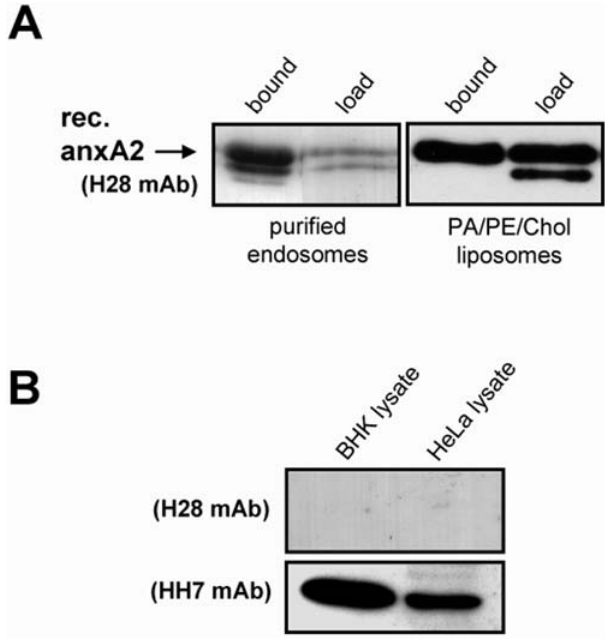
Figure 4. recombinant annexin A2 binding to endosome and liposome membranes. (A) Early endosomes (left panel) or PA/PE/ cholesterol liposomes (right panel) were prepared and incubated in vitro for 30min at 37 u C with 5 m g purified recombinant AnxA2 (AnxA2 H28 ). Membrane-bound and free AnxA2 were then separately recovered after high speed centrifugation, and analyzed by SDS gels and western blotting, as indicated. The faster migrating form of AnxA2 in panel A corresponds to the core domain of the protein lacking the N- terminus, and results from AnxA2 proteolytic cleavage. Note that the core domain does not become efficiently membrane-associated, as expected [15], (B) The recombinant mutant AnxA2 H28 is selectively detected with the monoclonal antibody H28 (see 4A), which does not detect WT AnxA2 [23], while the HH7 monoclonal antibody recognizes WT AnxA2 [10], as shown with blots of HeLa and BHK